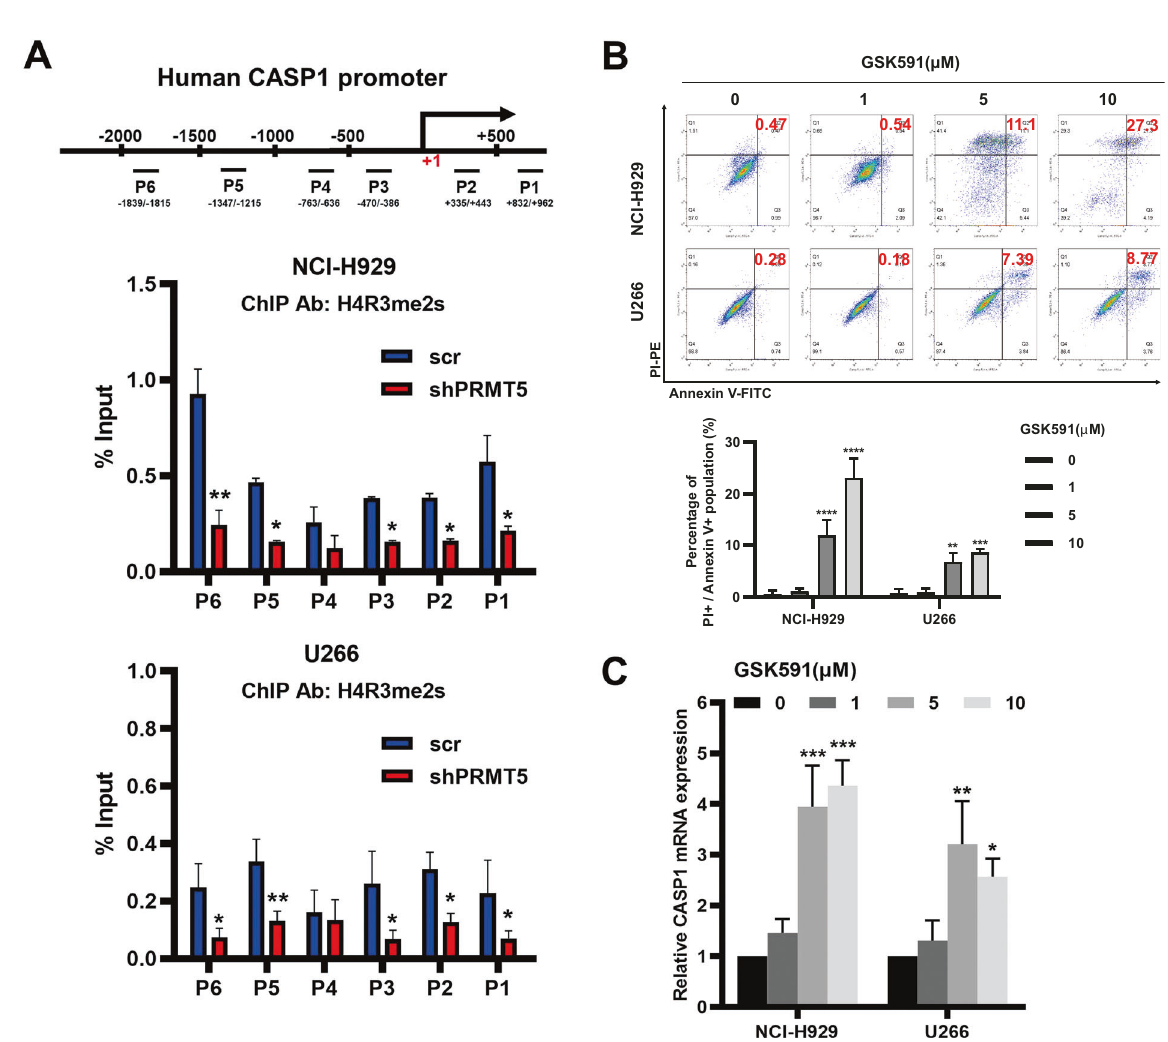
Fig. 5 Treatment of PRMT5 inhibitor GSK591 reduces the level of H4R3me2s at the CASP1 promoter. A Schematic drawing of the CASP1 promoter region. The positions of ChIP-qPCR primer set were labeled relative to the transcriptional start site (TSS). TSS is assigned as the ‘ + 1 ’ position. PRMT5-mediated H4R3me2s modi fi cations were signi fi cantly less enriched at the core promoter regions of CASP1 genes in NCI-H929 cells (upper panel) and U266 cells (lower panel) stably expressing PRMT5 shRNA than scr shRNA by ChIP analysis. IgG was used as a negative control. The bar graph shows percentages of relative fold enrichment of H4R3me2s at different positions across the CASP1 promoter region, compared with the input. B The analysis of Annexin V-FITC and PI by fl ow cytometry in NCI-H929 (upper panel) and U266 (lower panel) cells treated with 0, 1, 5, 10 μ M of GSK591. C Relative mRNA expression of CASP1 in NCI-H929 and U266 cells treated with 0, 1, 5, 10 μ M of GSK591. Data shown are mean ± SD ( n = 3). * P < 0.05, ** P < 0.01, *** P <